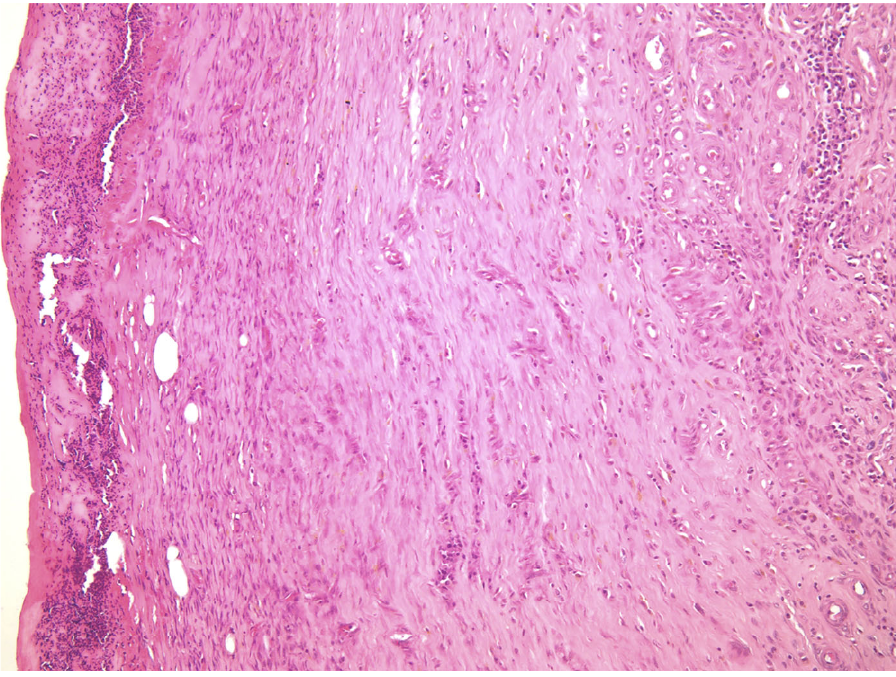
Figure A7. Histology of the wound treated with air at post ‐ operative day 21, hematoxylin and eosin staining, magnification—10×.